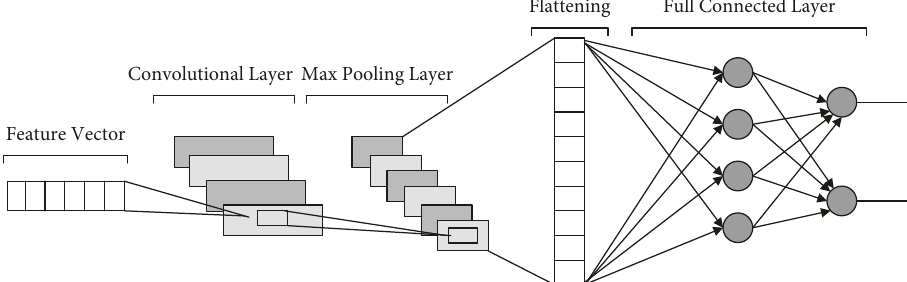
Figure 6: Convolutional neural network architecture.